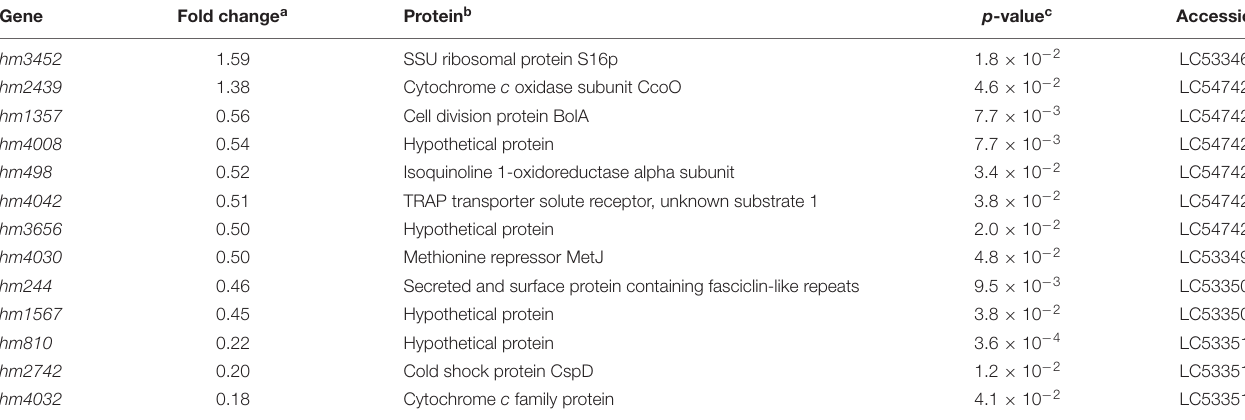
TABLE 4 | Change of protein expression in response to Lys concentration.